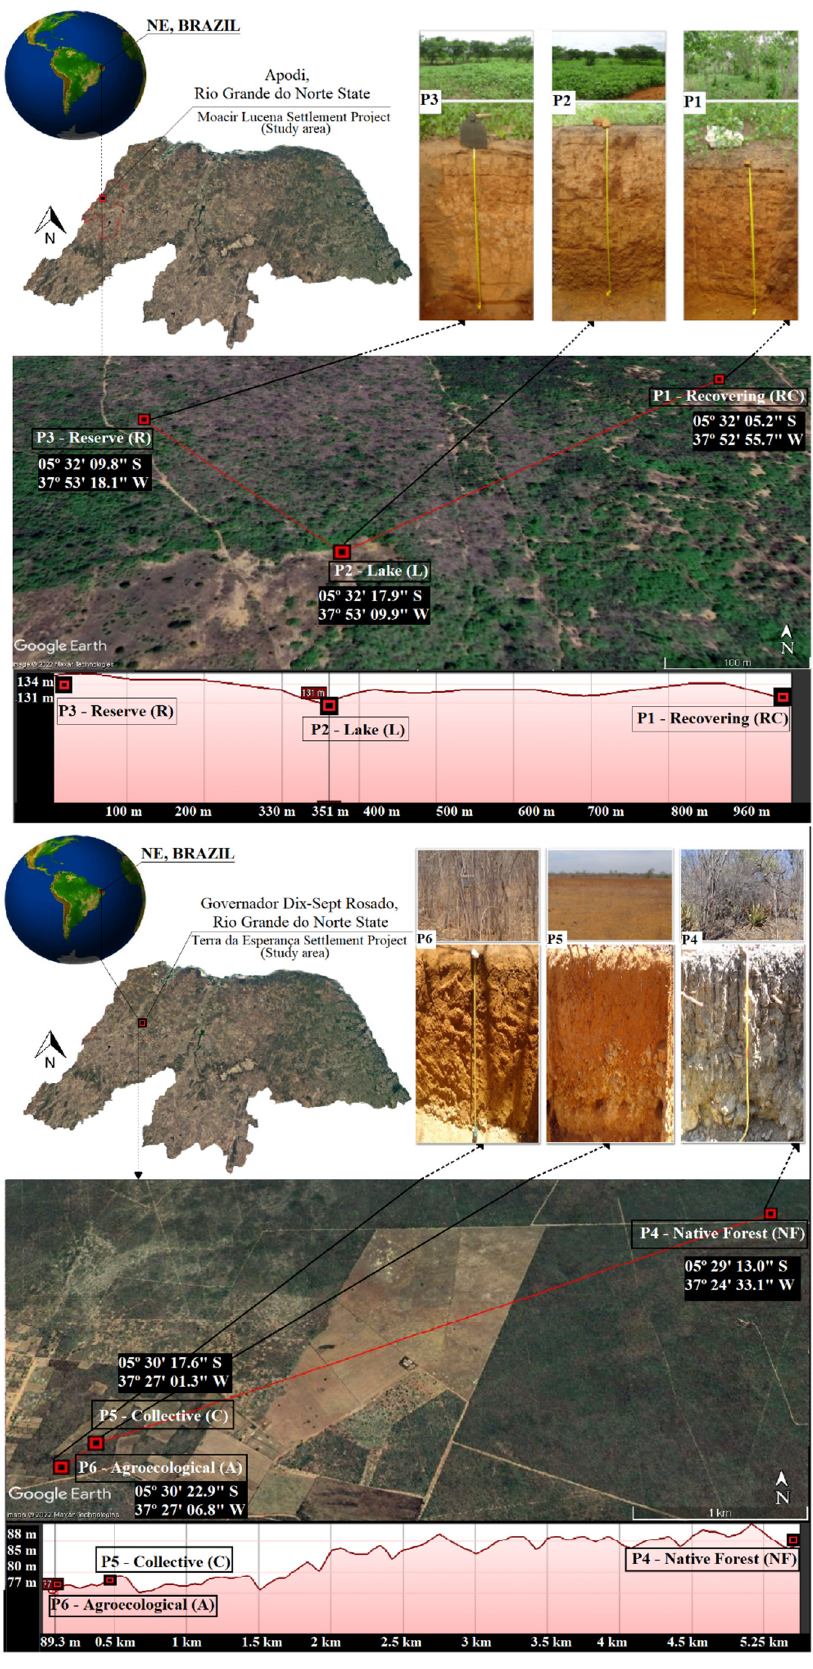
Figure 1. Location map of the study area of Governador Dix-Sept Rosado and Apodi in the northeast of Brazil.